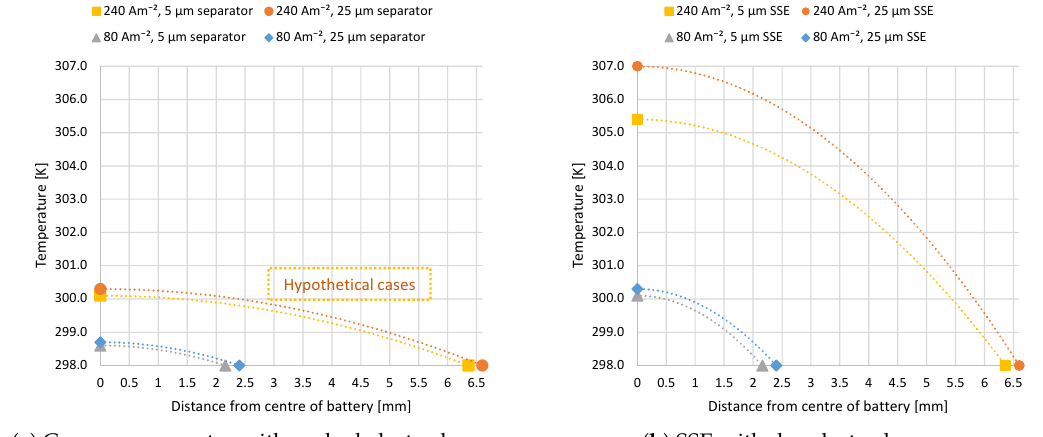
Figure 4. Temperature of the stack center (24 cells) compared to the outer boundary for batteries with the two different electrolytes, each with two possible SSE thicknesses (5 and 25 µ m): The 240 Am − 2 battery has three times thicker electrodes than the 80 Am − 2 battery; it is almost three times thicker for same number of cells and has three times the capacity. C-rate is four in all cases, and 240 Am − 2 is a hypothetical case for electrolyte-soaked